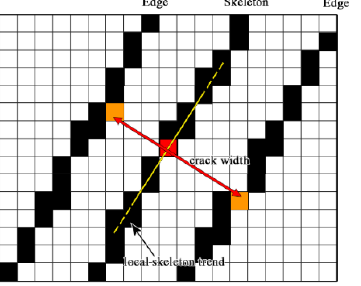
Figure 3 . Scheme of the modelled crack geometry, with the central skeleton chain and the edges. For each point of the skeleton, the two corresponding edge pixels are searched on the perpendicular direction to the local skeleton trend.